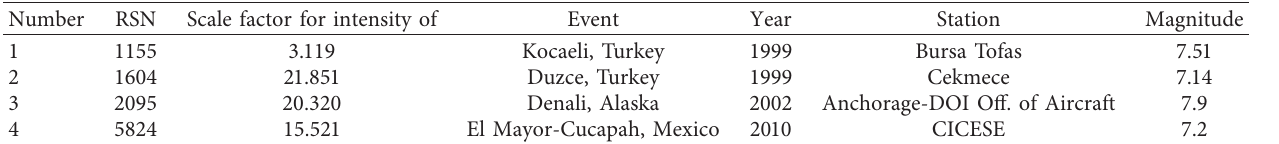
Table 4: Records and scale